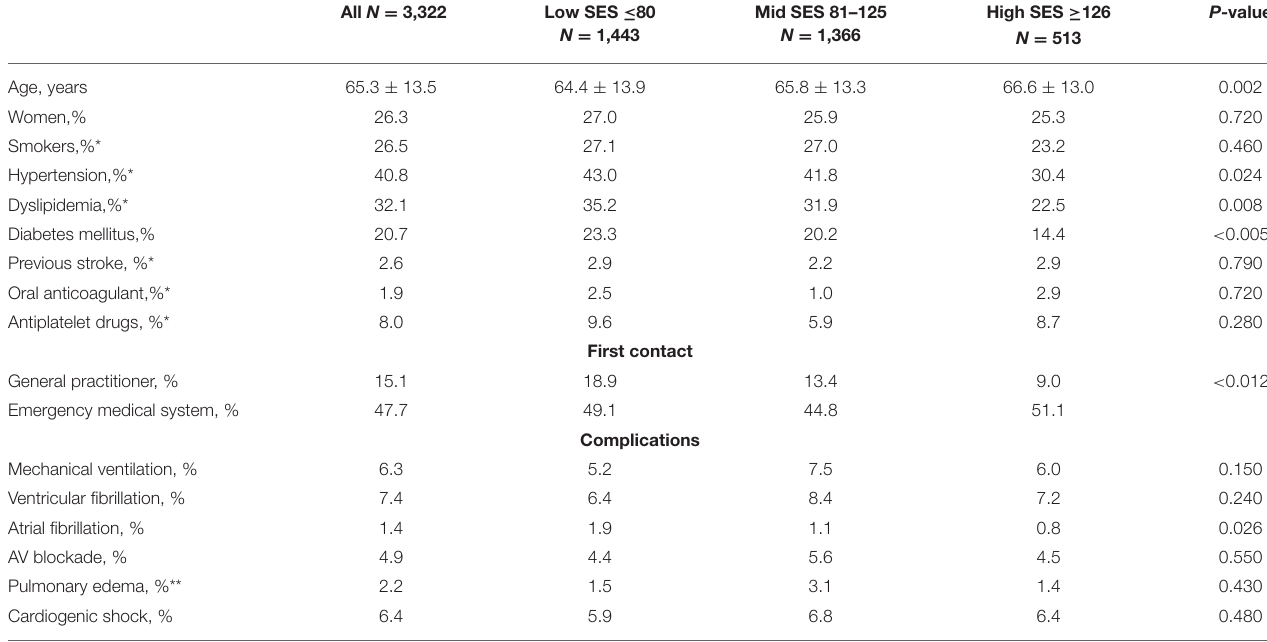
TABLE 1 | Baseline clinical characteristics according to socioeconomic status (SES)